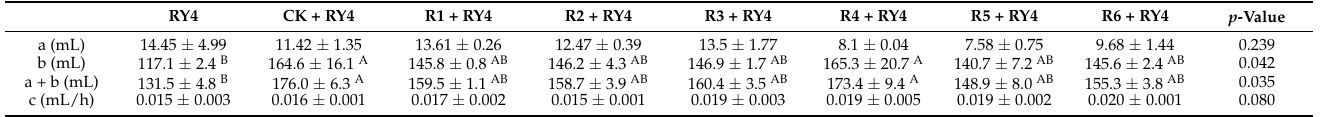
Table 5. In vitro fermentation gas production.